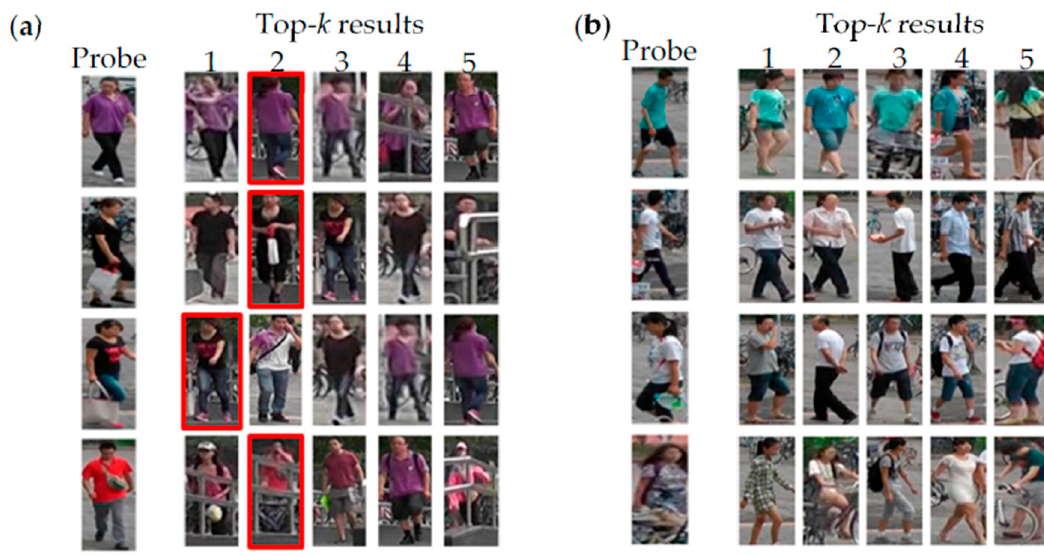
Table 5 . List of the identification rate in Experiment 1, Experiment 2 and Experiment 3 for the PRW dataset.